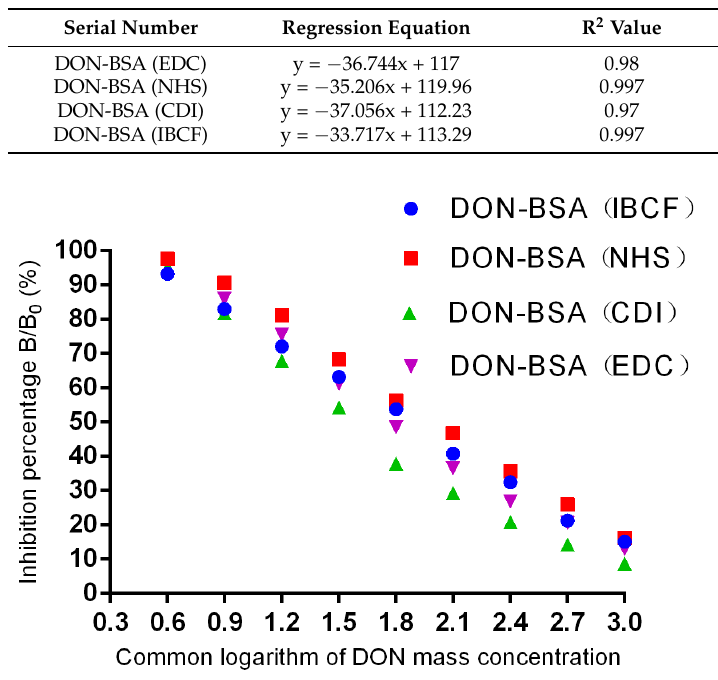
Figure 5. Inhibition curves of DON pAb.